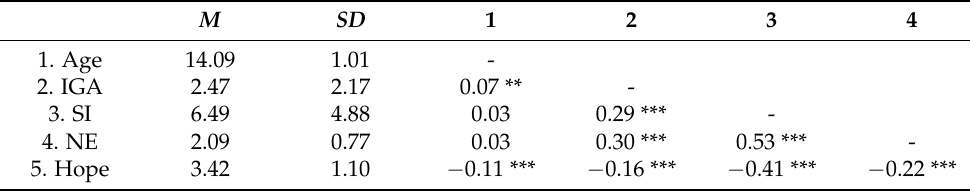
Table 2. Descriptive statistics results and correlation